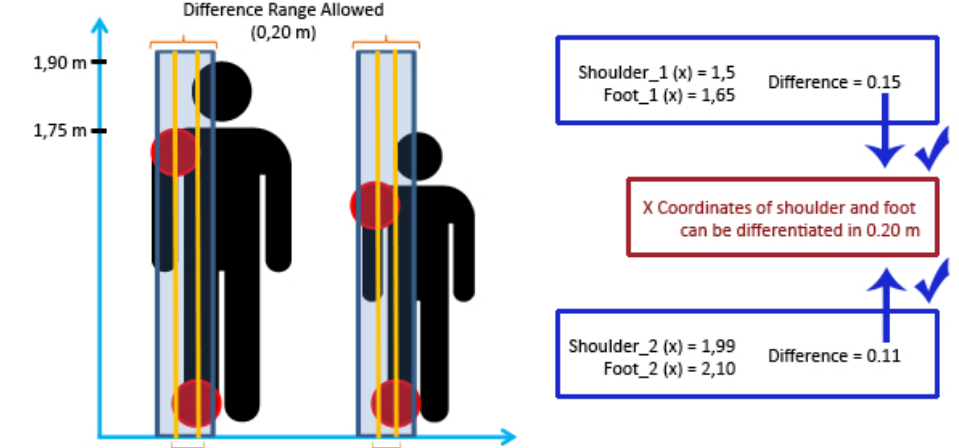
Figure 5. Example of the algorithm to check correct